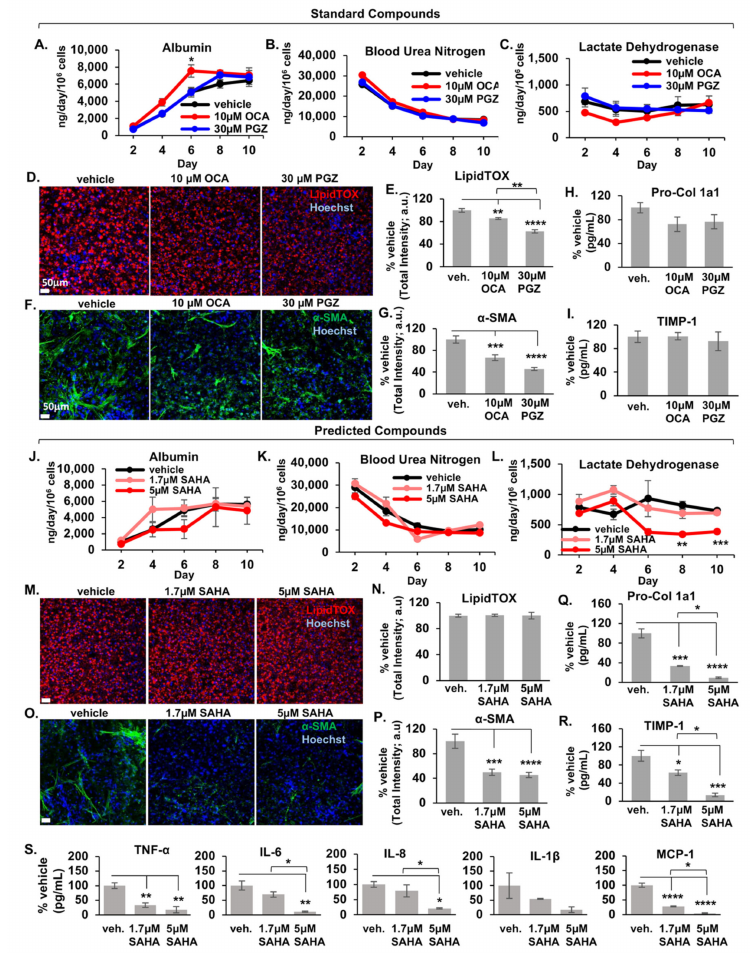
Figure 5. Control and predicted drugs reduce different NAFLD disease phenotypes in LAMPS models treated with EMS media. LAMPS models were maintained for 10 days in Early Metabolic Syndrome (EMS) media containing either vehicle control, 10 µ M obeticholic acid (OCA) and 30 µ M Pioglitazone (PGZ) [standard compounds], or vorinostat (suberoylanilide hydroxamic acid; SAHA) at 1.7 µ M or 5 µ M [predicted compounds]. A panel of metrics was examined to monitor disease-specific phenotypes. For standard drugs, albumin, blood urea nitrogen, and lactate dehydrogenase curves throughout the time course show similar profiles throughout the time course between vehicle and drug treatment groups, suggesting no overt model cytotoxicity or loss of function ( A – C ). At the day 6 timepoint, there was a significant increase in albumin secretion in the OCA group; however, no further significant increases in albumin output were observed at later time points (days 8 and 10). At day 10, there was a significant decrease in steatosis ( D , E ; LipidTOX TM intensity) and stellate cell activation ( F , G ; α -SMA intensity) for both OCA and PGZ groups compared to vehicle. Panels ( D , F ) display representative 20X image Day 10 LipidTOX TM ( D ) and α -SMA ( F ) images of LAMPS. Scale bar; 50 µ m. There was no significant change in the secreted levels of the pro-fibrotic markers Pro-Col 1a1 ( H ) TIMP-1 ( I ) in either treatment group compared to vehicle. For the predicted drug vorinostat (SAHA), albumin and blood urea nitrogen curves show no significant differences between vehicle and treatment groups ( J , K ), suggesting that these drug treatments do not result in loss of model functionality; however, a significant decrease in LDH secretion ( L ) at days 8 and 10 in the 5 µ M vorinostat treatment group, suggesting decreased cytotoxicity. This was further supported by the significant decrease in stellate cell activation ( O , P ; α -SMA intensity), production of the pro-fibrotic markers pro-collagen 1a1 and TIMP-1 ( Q , R ), and inflammatory cytokine production ( S ) observed in the vorinostat group. In